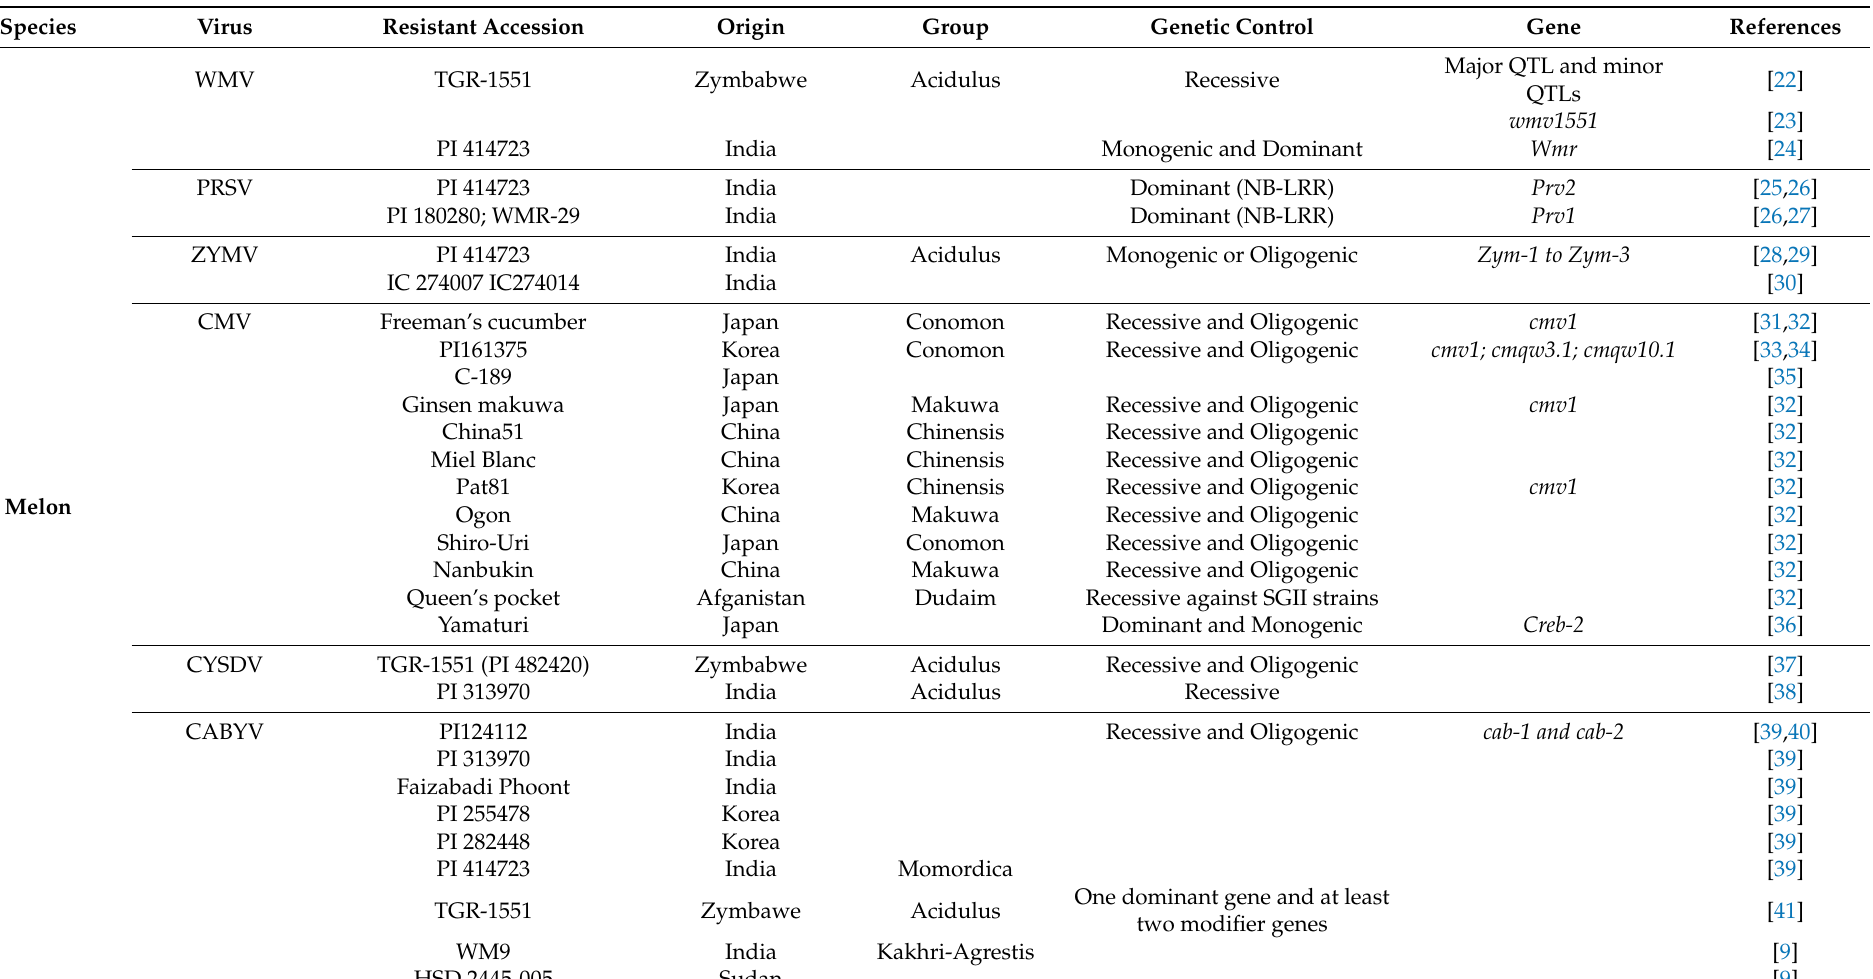
Table 1. Genetic resources for resistance to viruses in C.